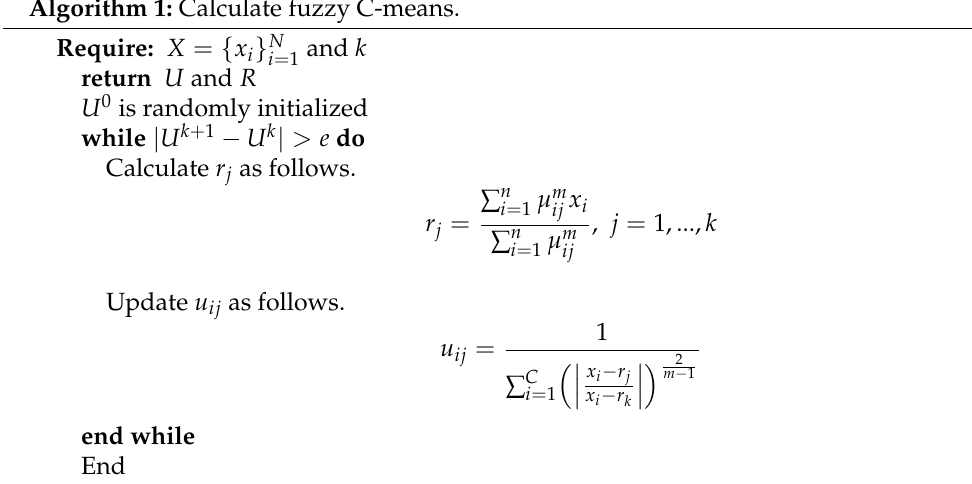
Algorithm 1: Calculate fuzzy